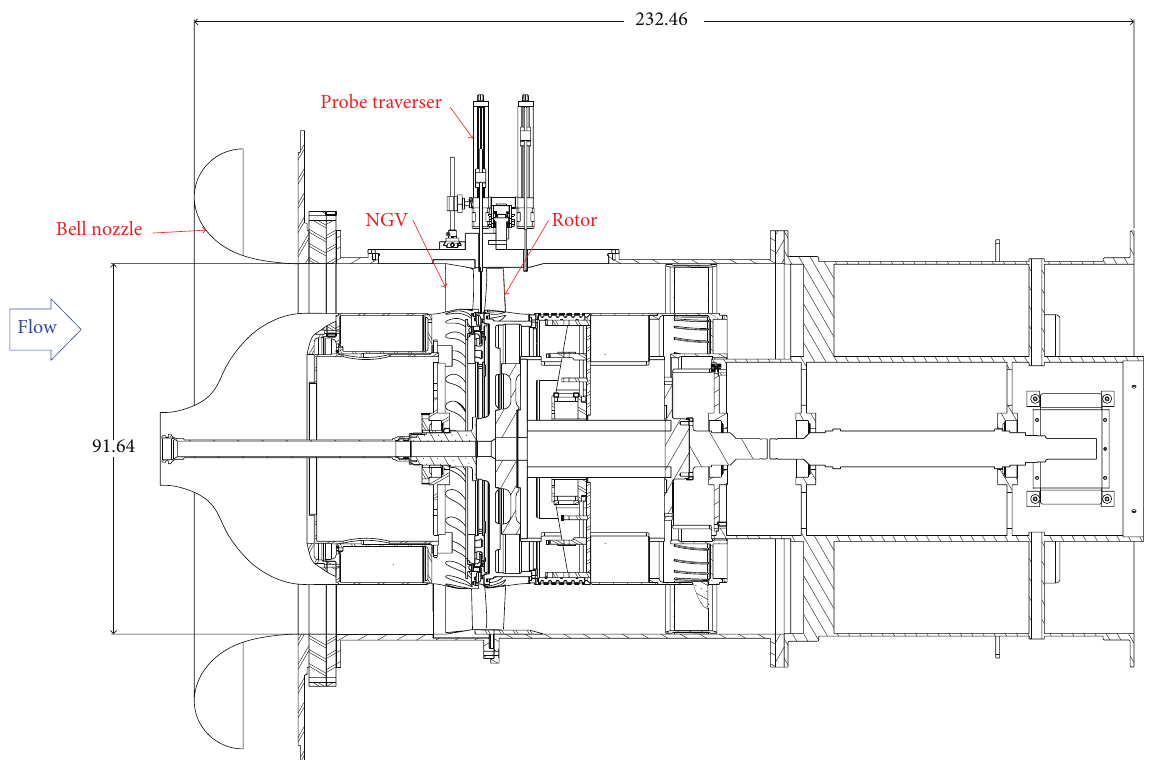
Figure 5: Axial Flow Turbine Research Facility (AFTRF) cutaway (dimensions in cm).